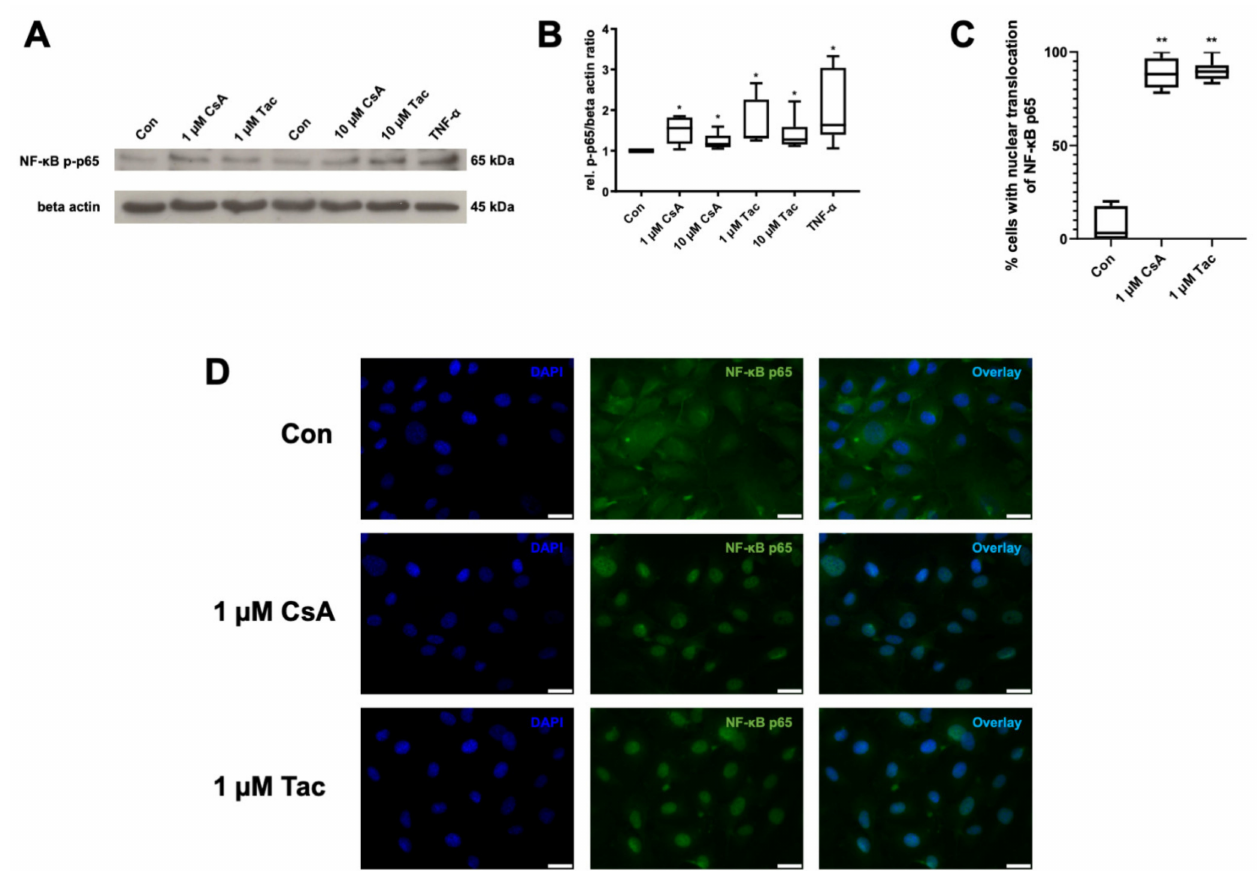
Figure 5. Cyclosporine A (CsA) and tacrolimus (Tac) induced phosphorylation and nuclear translocation of NF- κ B p65 subunit in ECFCs. ( A ) Representative immunoblot of NF- κ B p65 phosphorylation after 30 min treatment with CsA or Tac (1 or 10 µ M). TNF- α was used as positive control. ( B ) CsA and Tac significantly increased NF- κ B p65 subunit phosphorylation in ECFCs, n = 6, control group set as 1. ( C ) Quantification of ECFCs showing nuclear translocation of NF- κ B p65 subunit after treatment with 1 µ M CsA or 1 µ M Tac for 30 min compared to vehicle control. Cells were counted in 6 randomly taken images per treatment. ( D ) Representative immunofluorescence images showing NF- κ B p65 (green) nuclear translocation of ECFCs treated with CsA or Tac (1 µ M) for 30 min, nuclei were counterstained with DAPI (blue), scale bar 25 µ m, n =